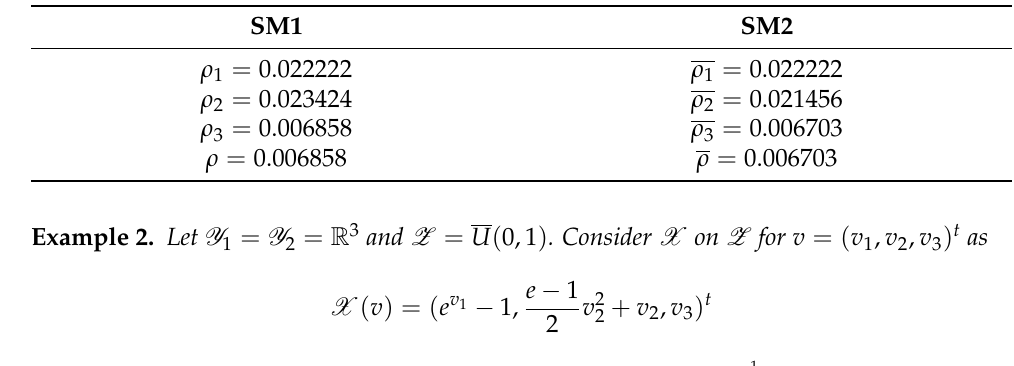
Table 1. Comparison of convergence radii for Example 1.